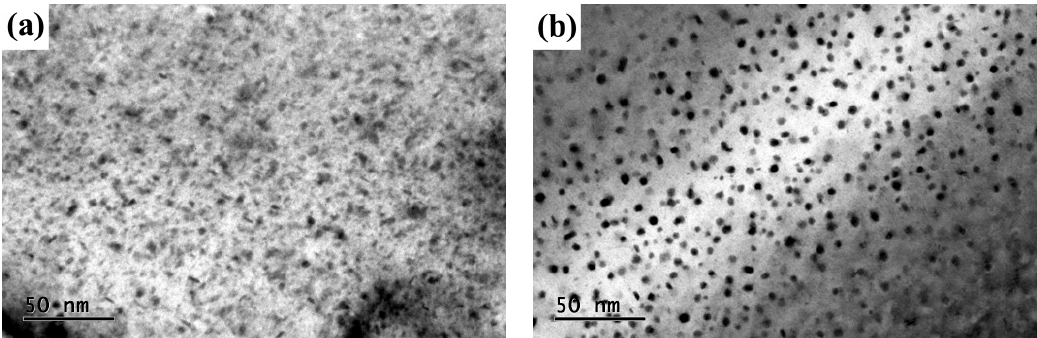
Figure 12. Comparison of the TEM micrographs of welded joints between as-welded and PWHT with solution at 490 °C for 80 min followed by aging at 120 °C for 24 h: ( a ) as-welded and ( b ) 490 °C, 80 min.